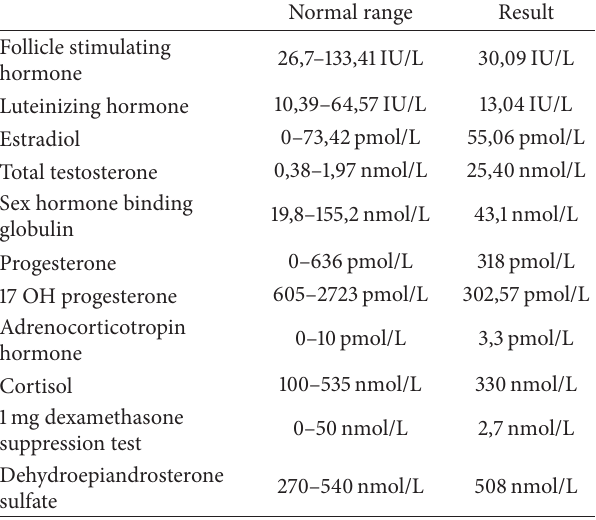
Table 1: Hormonal profiles of